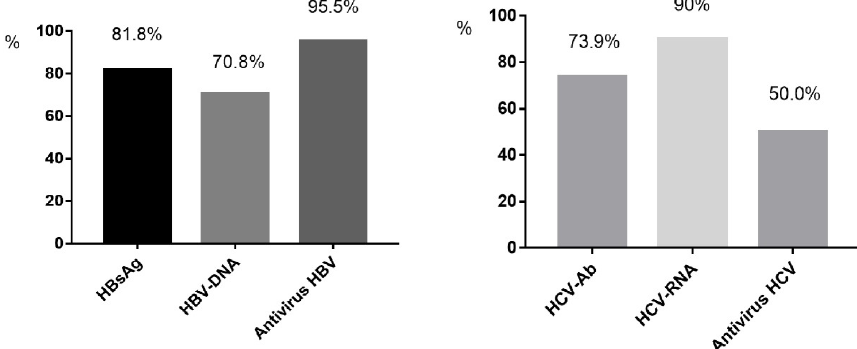
Figure 2. The proportion of HIV-positive inpatients accepting screening and anti-virus treatment. HBsAg: the screening proportion of HBsAg among HIV-positive inpatients. HCV-Ab: the screening proportion of anti-HCV among HIV-positive in patients. HBV-DNA: the screening proportion of HBV-DNA among HBV/HIV co- infected inpatients. HCV-RNA: the screening proportion of HCV- RNA among anti-HCV- positive inpatients with HIV infection. Antivirus HBV :the proportion of anti- HBV treatment among HBV/HIV co- infected patients. Antivirus HCV: the proportion of anti- HCV treatment among HCV/HIV co-infected inpatients.